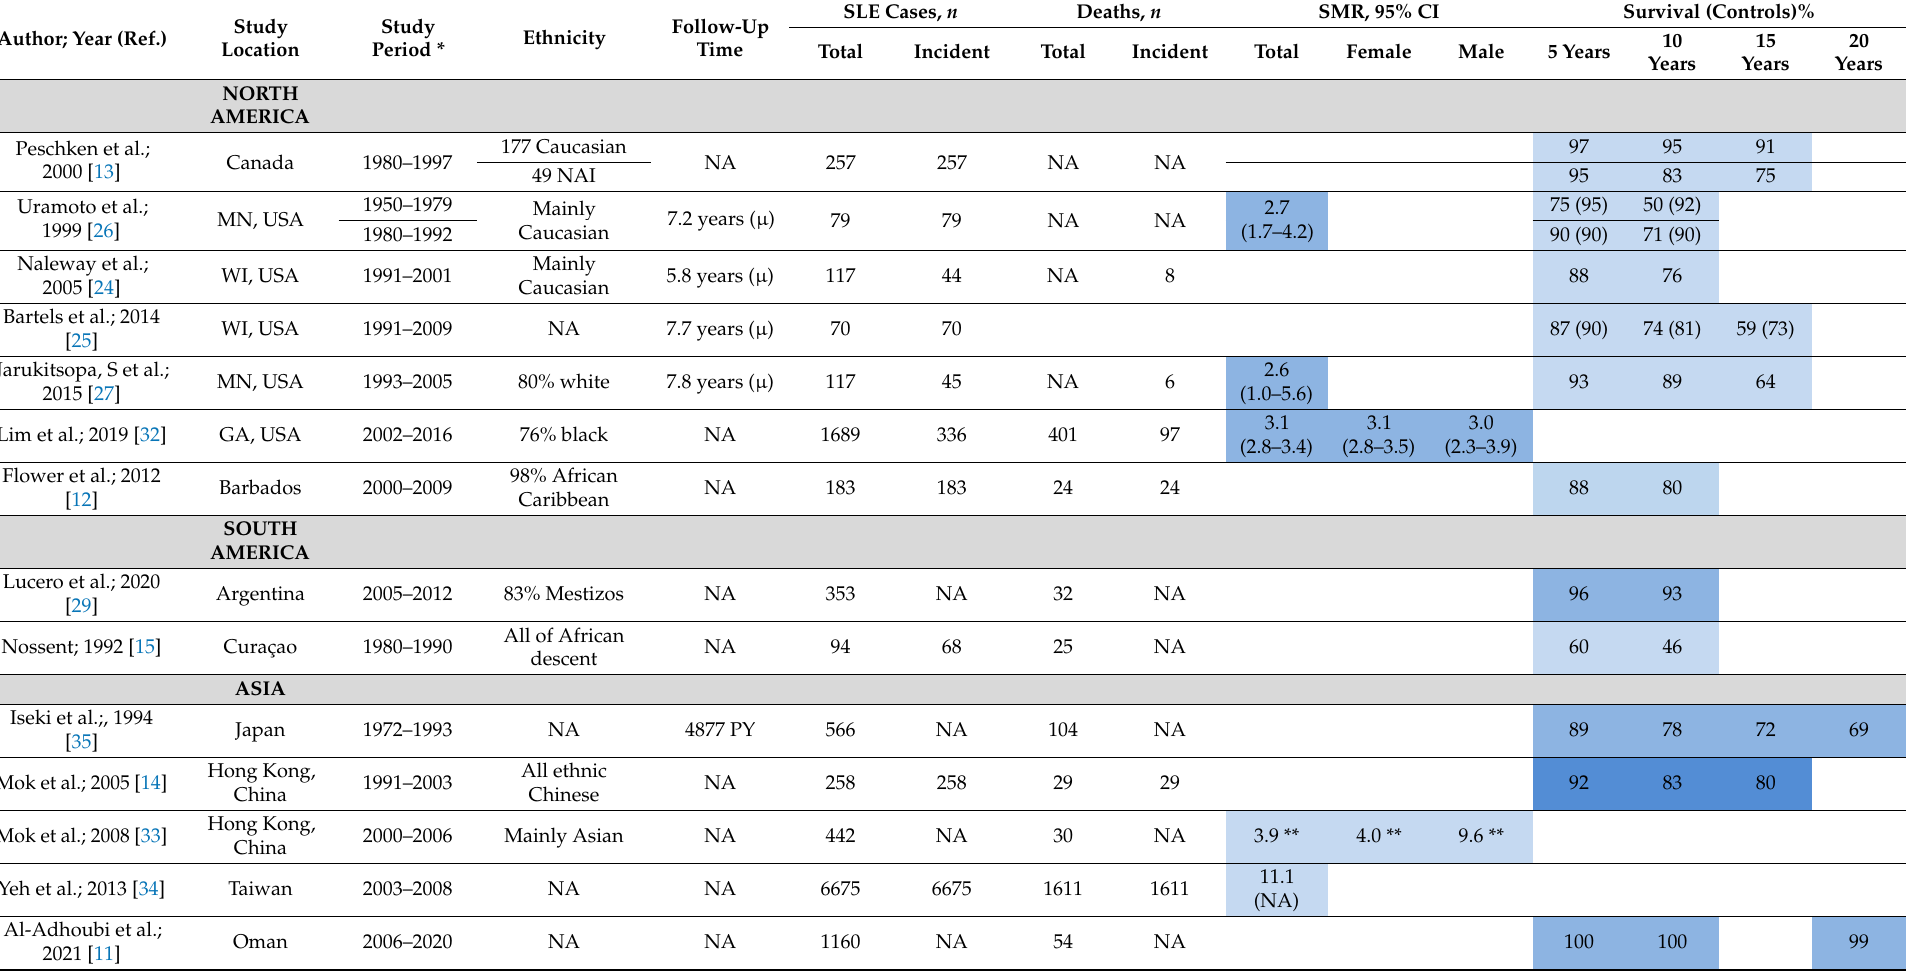
Table 1. Survival and standardized mortality rate (SMR) in Systemic Lupus Erythematosus, from population-based